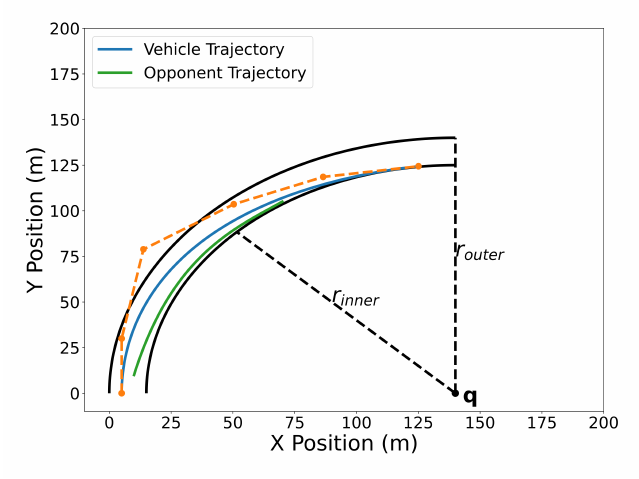
Figure 31. Overtaking trajectory. The track follows a quarter circle whose center point is at q . The inner track line has a radius of r inner and the outer track line has a radius of r outer .